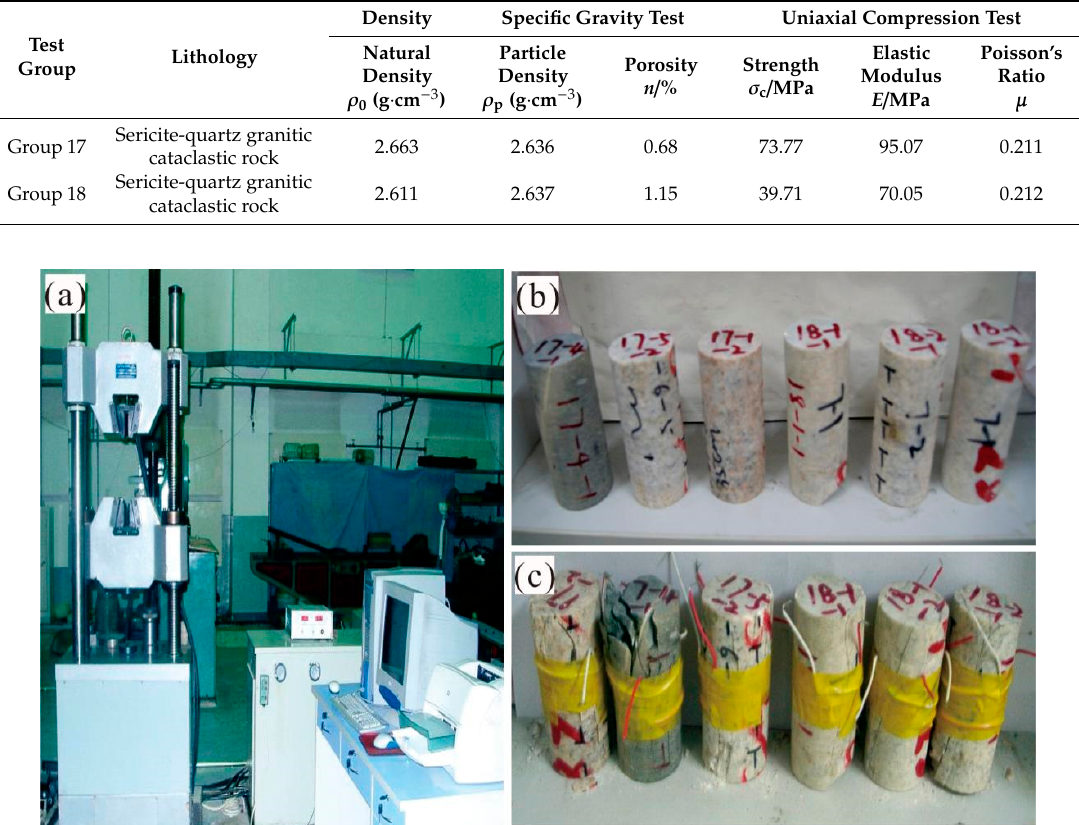
Figure 3. Geological tectonic map of the mining area. Table 1. Result of laboratory testing.